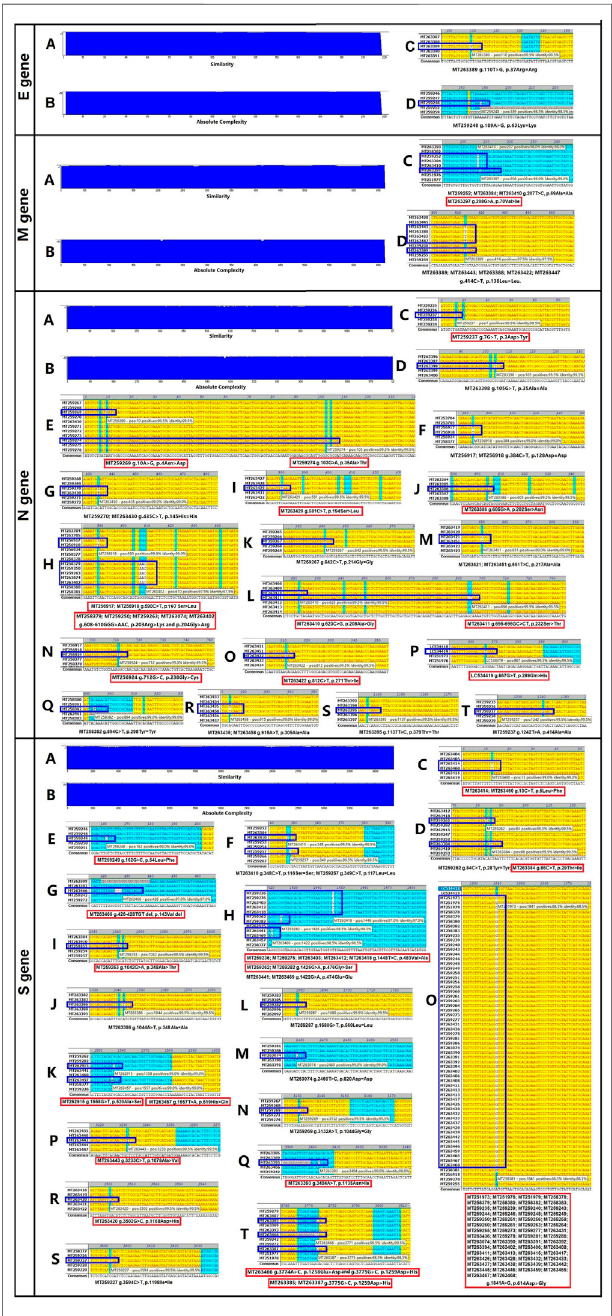
FIGURE 1 | Absolute diversity and variations in the structural genes of 200 severe acute respiratory syndrome coronavirus-2 (SARS-CoV-2) isolates. The similarity and absolute diversity in structural genes sequenceswere very high. Two SARS-CoV-2 isolates had twosingle nucleotide polymorphisms (SNPs) within the E gene, nine isolates had three variations (one mutation and two SNPs) within the M gene, 28 strains had 22 variations (13 mutations and nine SNPs) within the N gene, and 89strainshad 25variations(16mutations and nineSNPs) within theS